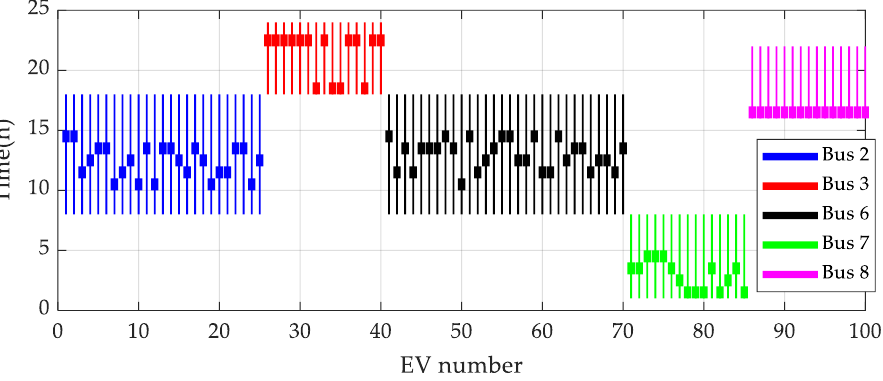
Figure 5. The EV scheduling determined after the first stage of OARPC for the selected